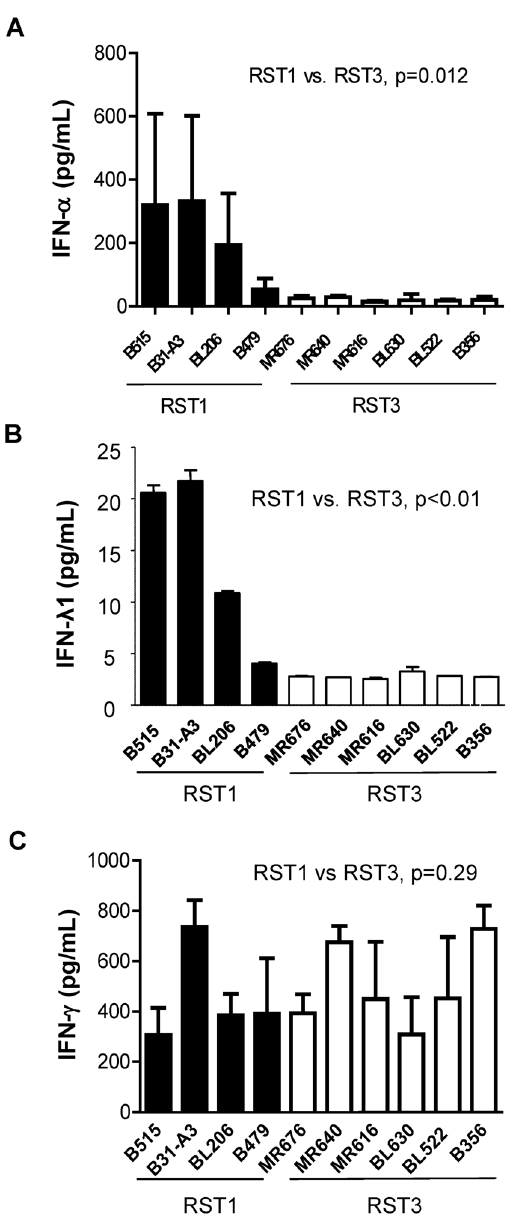
Figure 1. RST1 isolates induce expression of multiple interfer- ons. Human PBMCs (4 6 10 6 ) were co-incubated for 20 hrs with RST1 (black bars) or RST3 (white bars) B. burgdorferi clinical isolates (4 6 10 7 ) (MOI=10:1). Concentrations of human IFN- a ( A ), IFN- l 1/IL29 ( B ), or IFN- c ( C ) proteins in cell-free culture supernatants were quantitated by ELISA ( A , B ) or cytometric bead array ( C ). Columns represent the mean 6 SD of values from three blood donors assessed in independent experiments, with the exception of ( B ) which represents results from a single donor. Statistical analysis was performed using a non-parametric, two-tailed Mann-Whitney